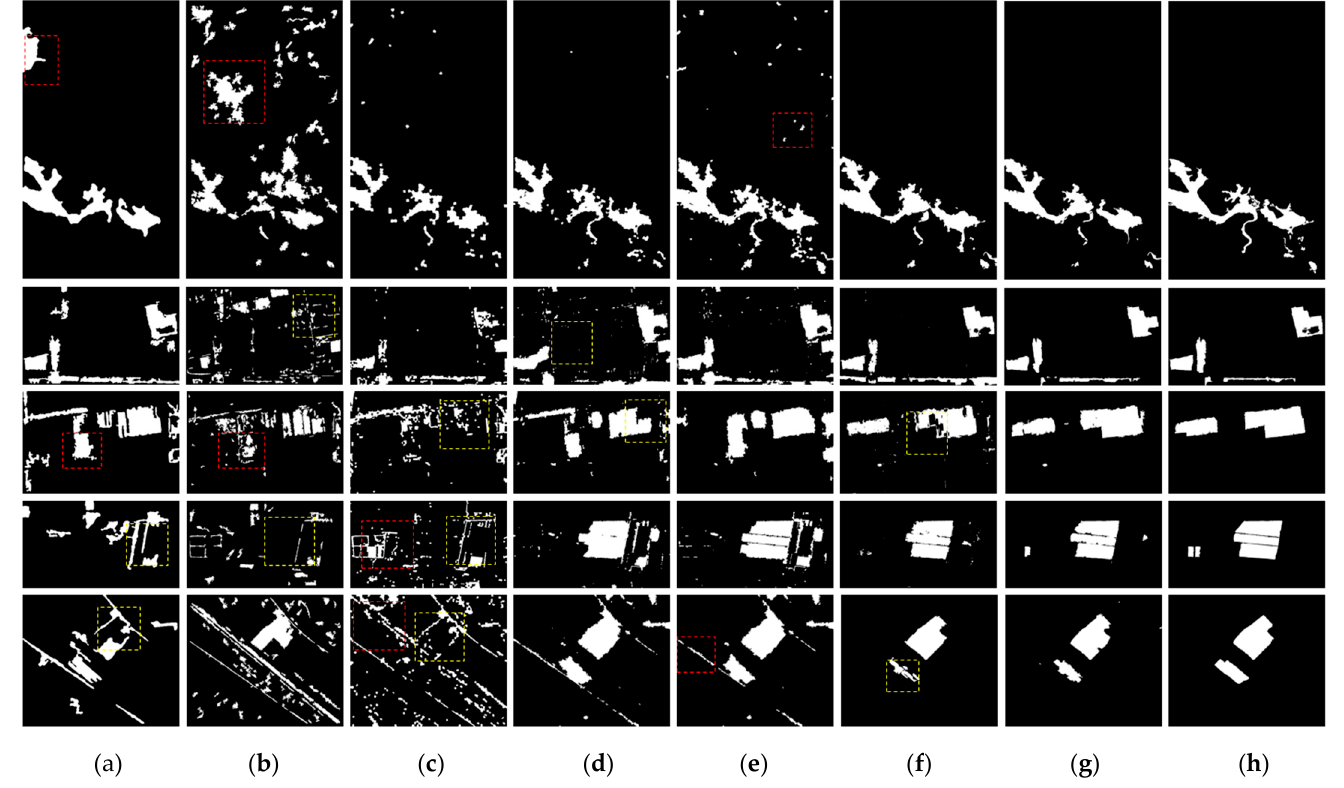
Figure 14. Change maps by different methods on the heterogeneous Optical/SAR data sets. ( a ) FPMS. ( b ) CICM. ( c ) IRG-MCS. ( d ) SCASC. ( e ) GIR-MRF. ( f ) MSGCN. ( g ) DNHGNN. ( h ) Reference change map.